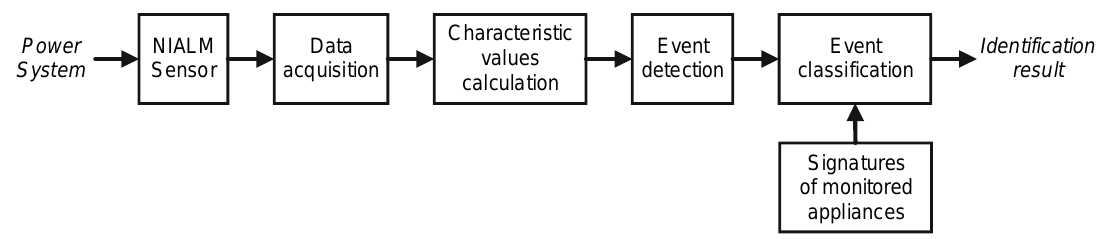
Figure 2. General architecture of a nonintrusive appliance load monitoring system.